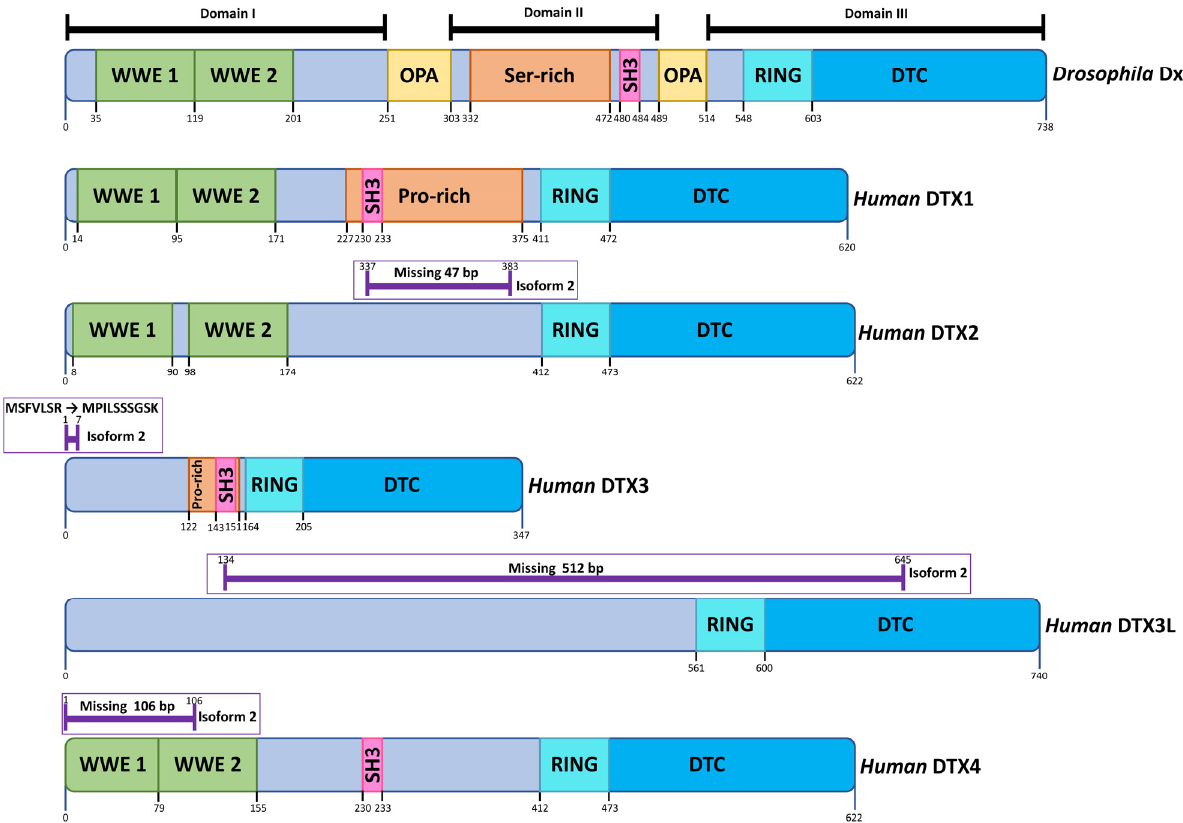
Figure 2. Human Deltex Isoforms. DTX proteins all have in common a conserved C-terminal region comprising a RING domain E3 ubiquitin ligase and a DTC domain. Drosophila Deltex can be divided into three subdomains (I-III) separated by poly Q rich regions (OPA). DTX1, DTX2, DTX4 and Drosophila Deltex have in common 2 WWE domains, which are Notch-binding regions that interact with the Ankyin domain region of the Notch ICD. Proline-rich regions, in some cases including the PPLP motif that comprises SH3 binding sites, are indicated where present. Drosophila Deltex additionally has Q-rich repeat regions (OPA repeats), which separate the N- and C-terminal domain regions from the central Serine-rich region. Variations arising from alternative splicing are indicated on the figure with horizontal purple lines (https://www.uniprot.org accessed 18 October 2021) [33].